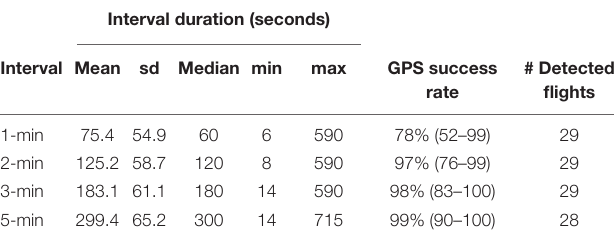
TABLE 3 | Variation in interval duration (seconds), GPS success rate (max–min), and number of flights detected using changepoint analysis with MBIC penalty, for different positioning frequencies down-sampled from original 1-min resolution wolf GPS data from experimental human approach